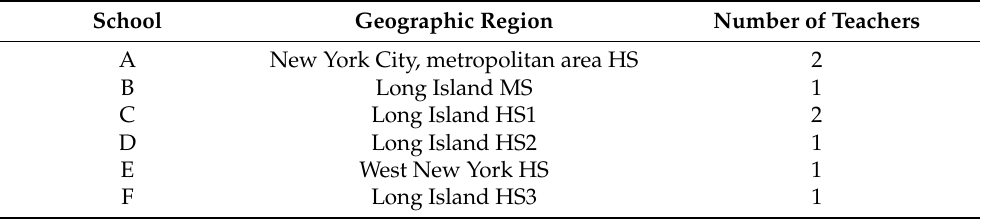
Table 1. Demographic Information by